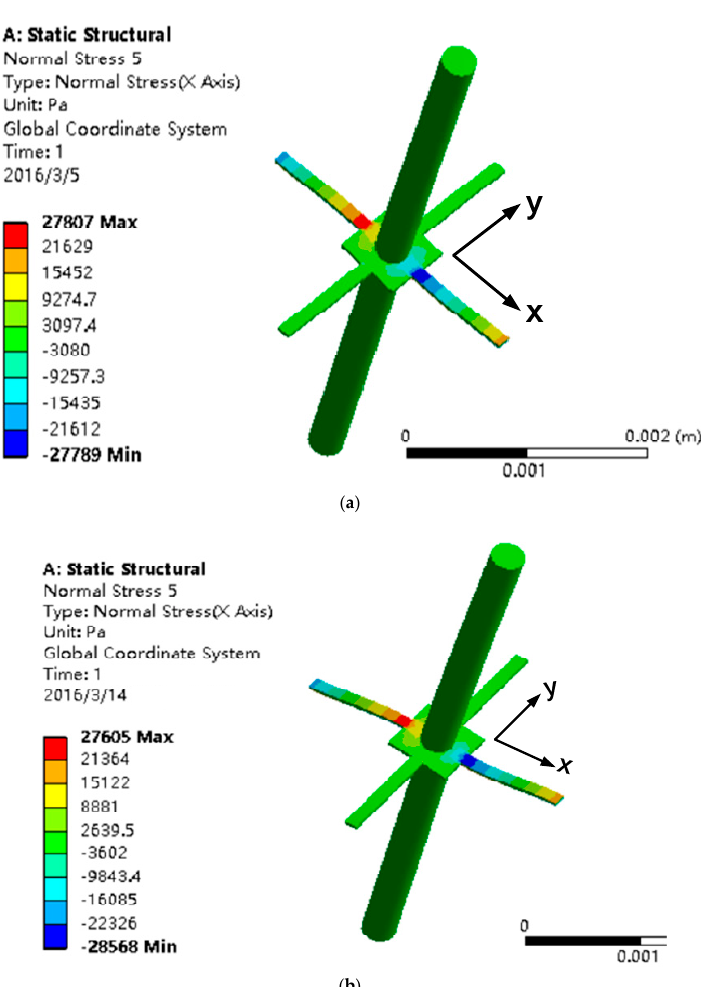
Figure 12. Stress response. ( a ) The upper cilia is subjected to 1 μ N along the X-direction; ( b ) the upper cilium is subjected to 2 μ N along the X-direction and 2 μ N along the Y-direction, and the lower cilium is subjected to 1 μ N in the X-direction and 2 μ N along the